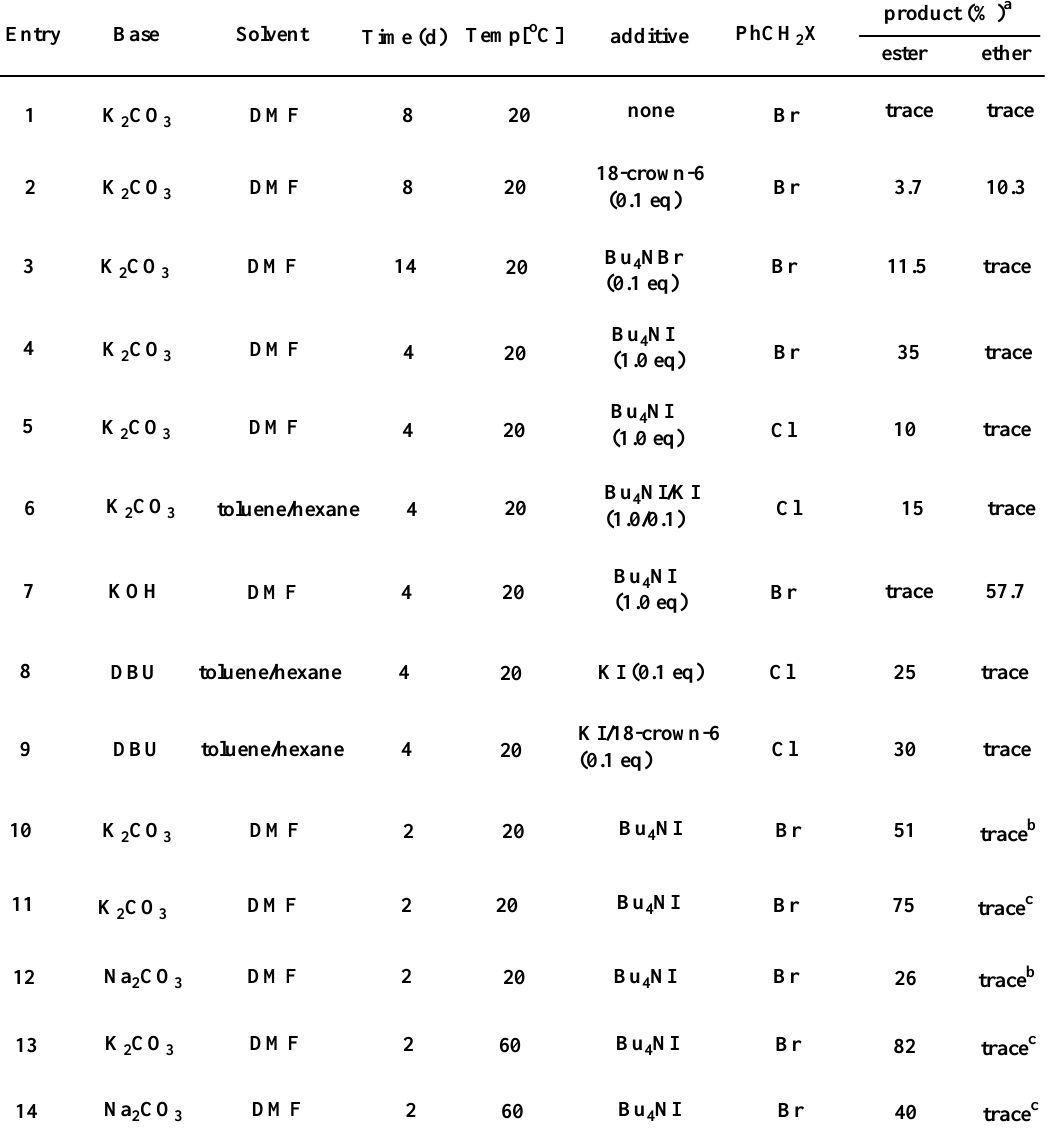
Table 1. Reactions of PhCH 2 OH (1.0 eq) with PhCH 2 X (1.0 eq) (X= Cl, Br) in the presence of additives (0.1 ~ 5.0 eq) under CO 2